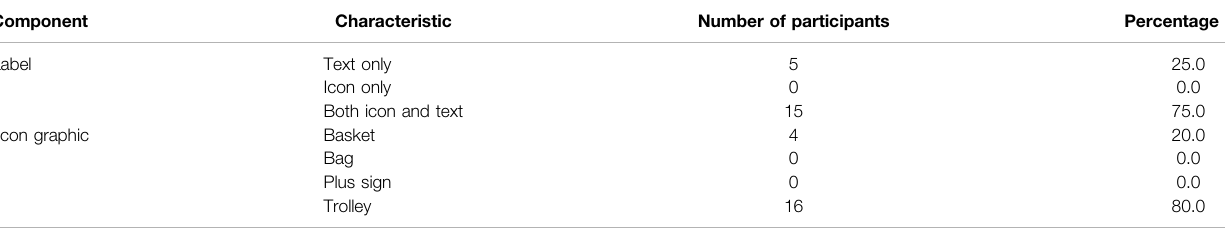
TABLE 4 | Characteristics of label of “ add to cart ” button preferred by participants. Component